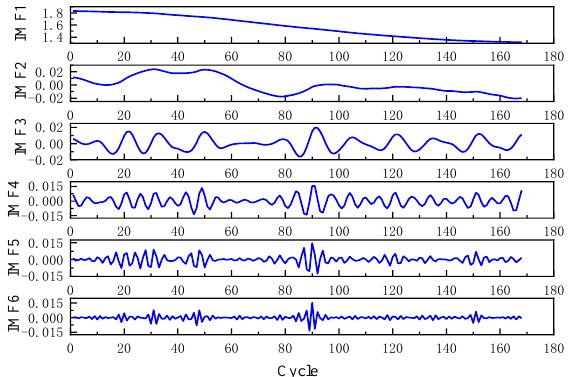
Figure 8. Decomposition effect when K = 6, α = 100.